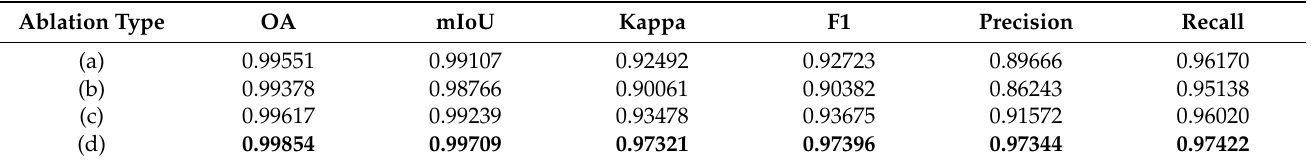
Table 6. Ablation experiments on different recognition indice sets. (a), (b), (c), and (d) indicate the different indice sets for landslide recognition. Bold values mean the highest number of the corresponding evaluation